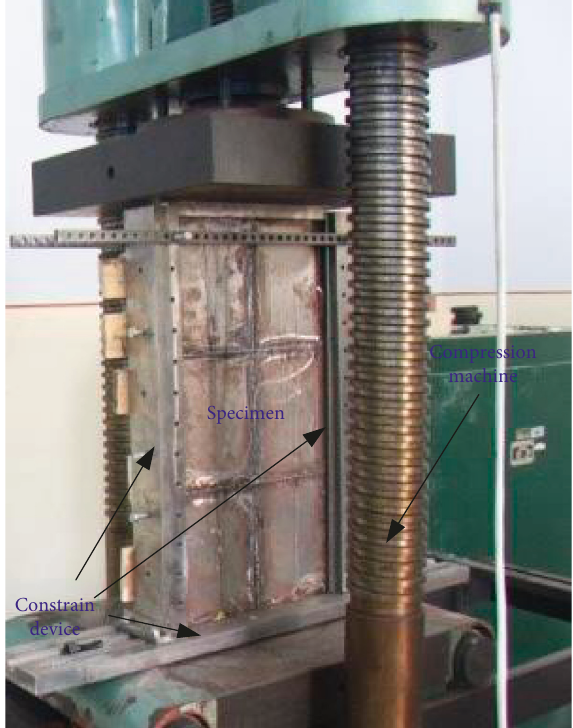
Figure 18: SPS buckling experiment.